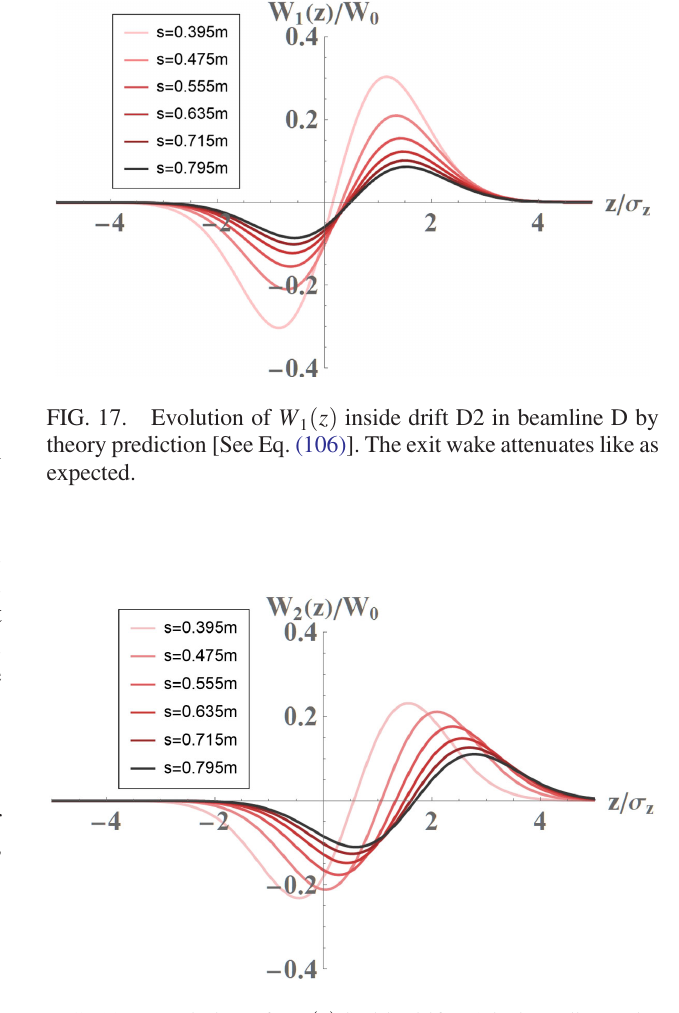
FIG. 18. Evolution of W 2 ð z Þ inside drift D2 in beamline D by theory prediction [See Eq. (106)]. As s increases the wake “ moves ” toward positive z and attenuates.